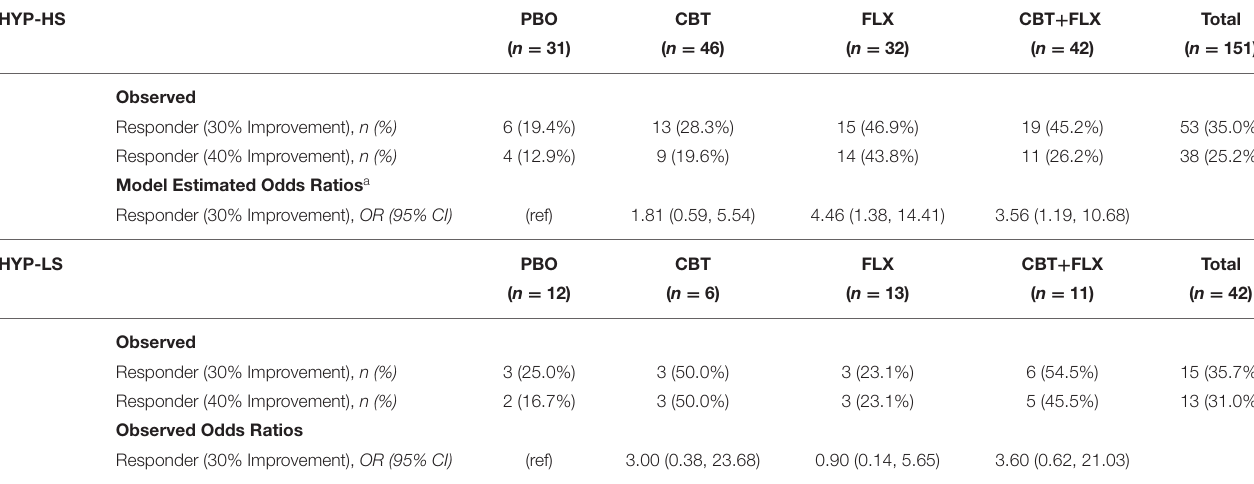
TABLE 2 | Observed Responder Status and Model Estimates by randomly assigned treatment group in HYP-HS and HYP-LS patients.